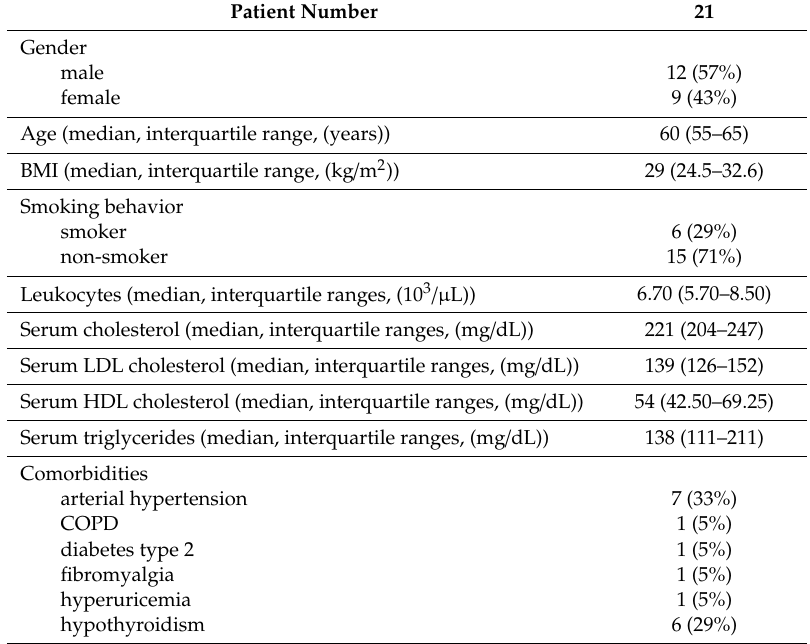
Figure 7. Flow chart of patients undergoing coronary angiography included in this study. Table 8. Characteristics of patients suffering from coronary heart disease included in this study (data before coronary angiography).